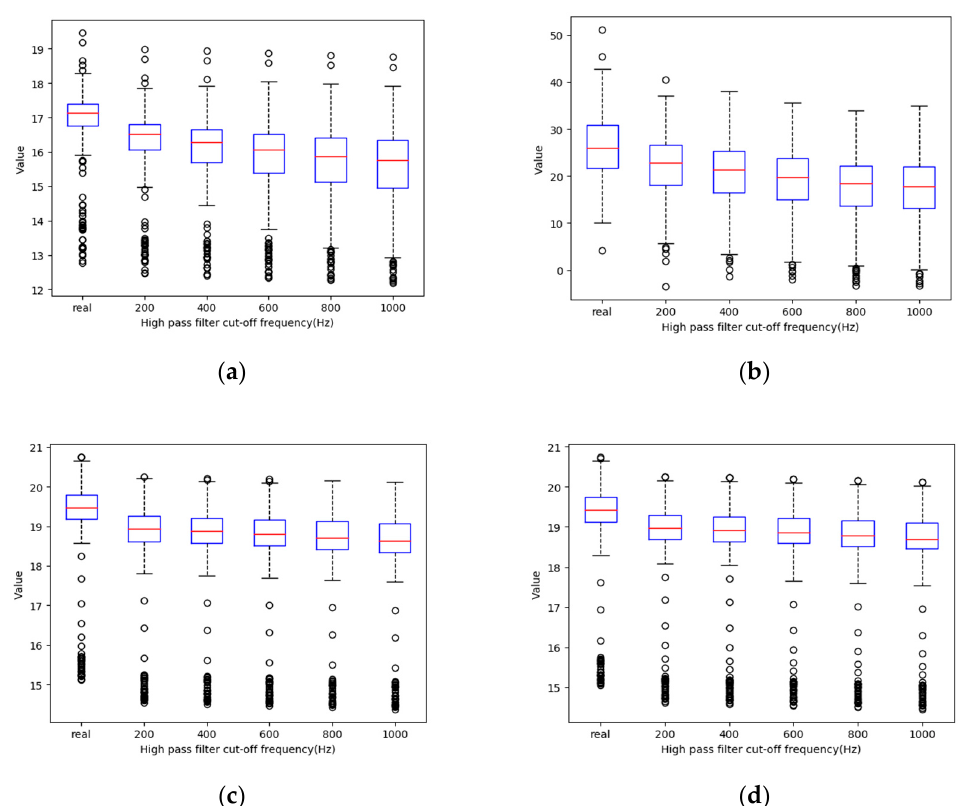
Figure 3. Distributions of the MFCC components for the real and fake stereo audios (real denotes the real stereo audio, 200 to 1000 denotes the fake stereo audio ( f cut − of f are 200 Hz to 1000 Hz, respectively)). ( a ) First component of right channel in FILM ( b ) 2nd component of left channel in FILM ( c ) 1st component of right channel in MUSIC ( d ) 2nd component of left channel in MUSIC.